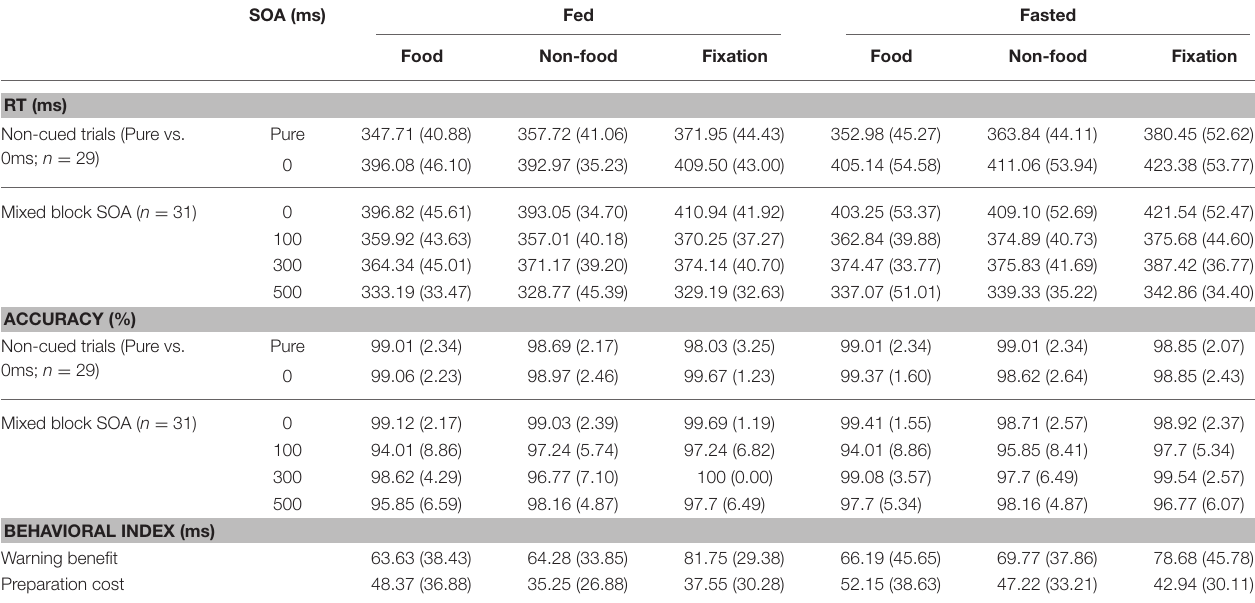
TABLE 2 | Mean (standard deviation) RT and accuracy for the non-cued trials (in the pure and mixed blocks) and for each SOA (in the mixed blocks), and mean behavioral index of proactive inhibition for each stimulus type in the fed and fasted state. SOA (ms) Fed Fasted Food Non-food Fixation Food Non-food